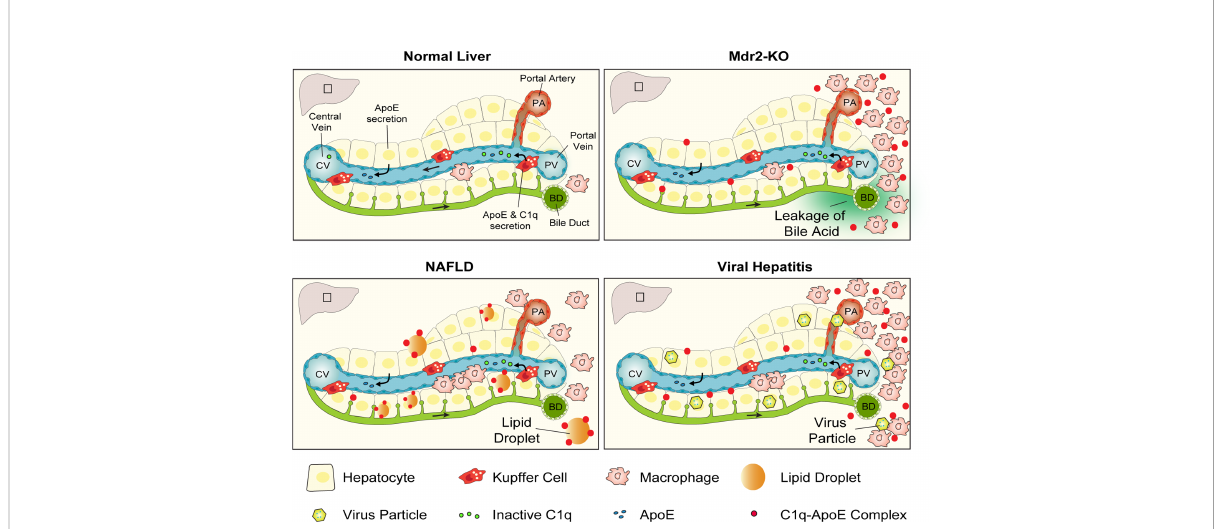
FIGURE 9 Graphical representation of the C1q-ApoE complex as a new hallmark pathology of diseased liver tissue. In normal liver tissue C1q is secreted into the circulation as an inactive preprotein by KCs as well as monocyte-derived macrophages. ApoE is secreted into the circulation by KCs and hepatocytes. Due to the leakage of bile acid in the portal tract areas of Mdr2-KO mice immune cell in fi ltrates develop and C1q gets activated and formation of the C1q-ApoE complex is initiated. In NAFLD, C1q is likely to be activated by lipid and in viral hepatitis by virus particles or secondary activators leading to the formation of the C1q-ApoE complex. Schematic Figure modi fi ed from (29) with the permission of the